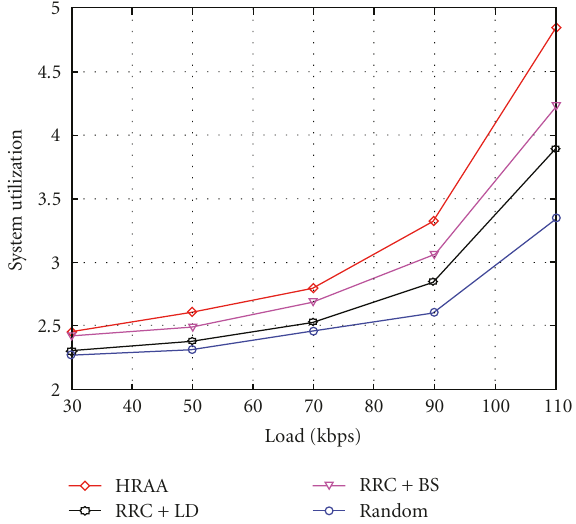
Figure 5: The 50th percentile of the average cell throughput for di ff erent load.